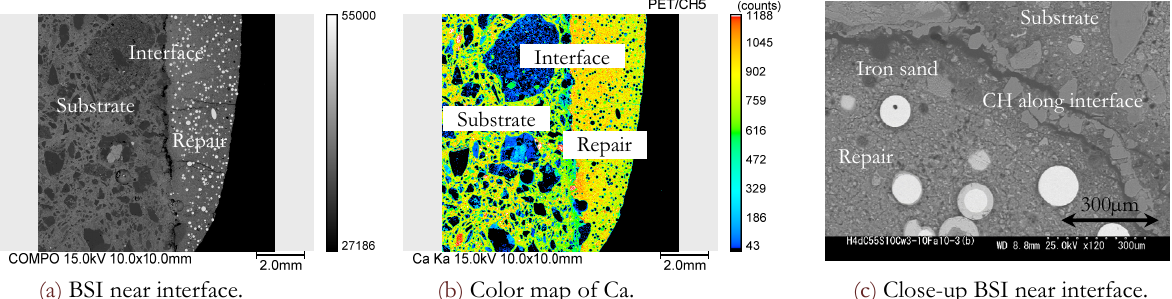
Figure 2: SEM observation of Specimen (H2dC4S10Fa10-3) near interface.